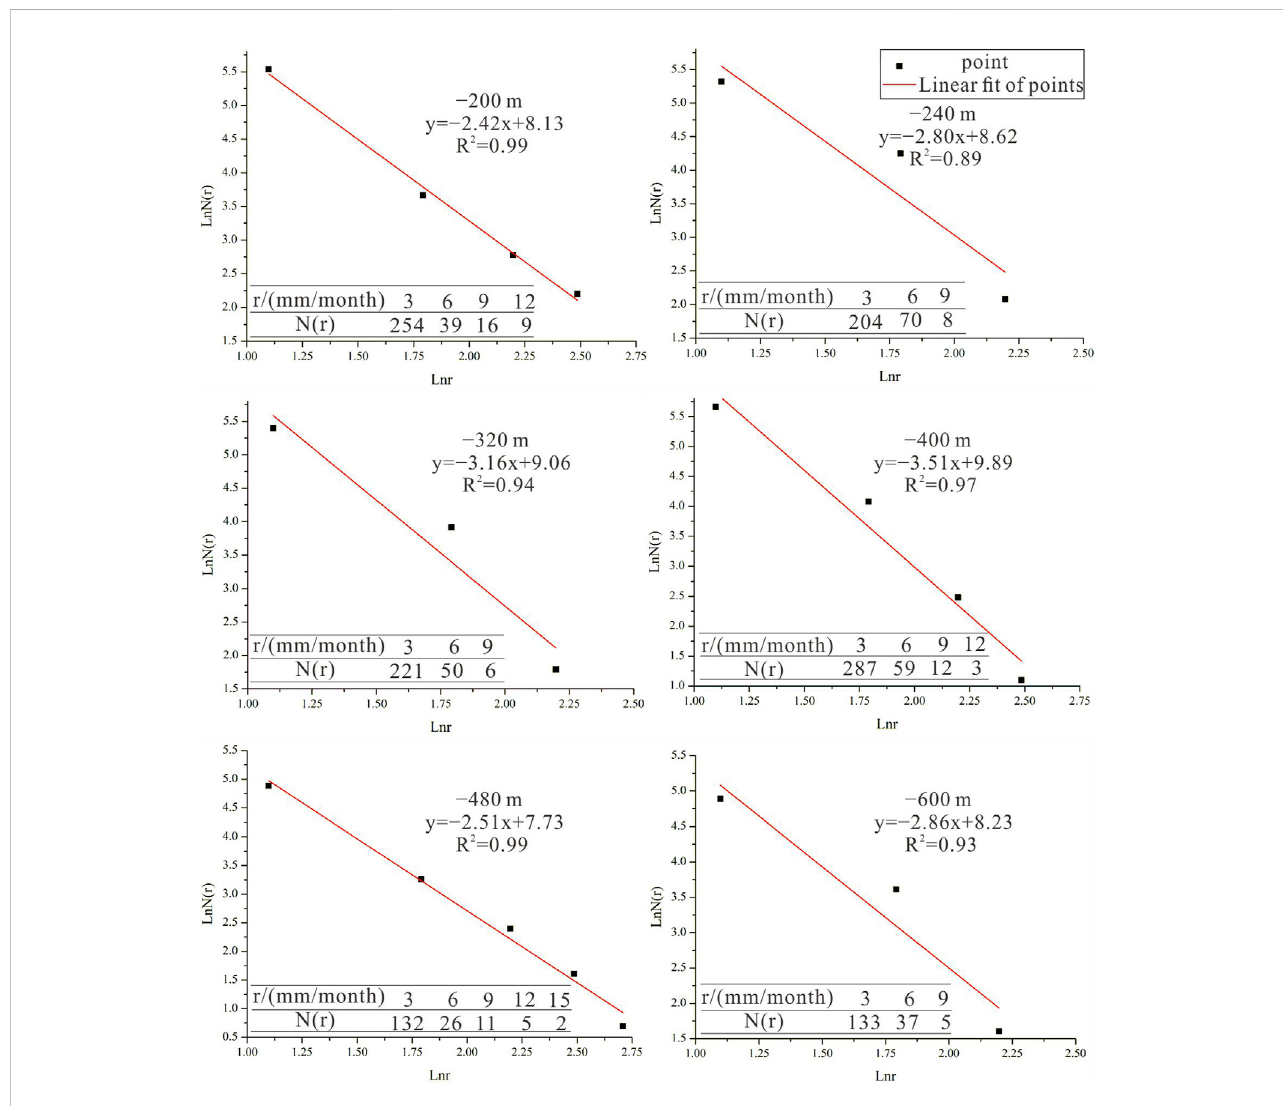
FIGURE 13 Fractal dimensions of various sublevels of the No. 55 prospecting pro fi